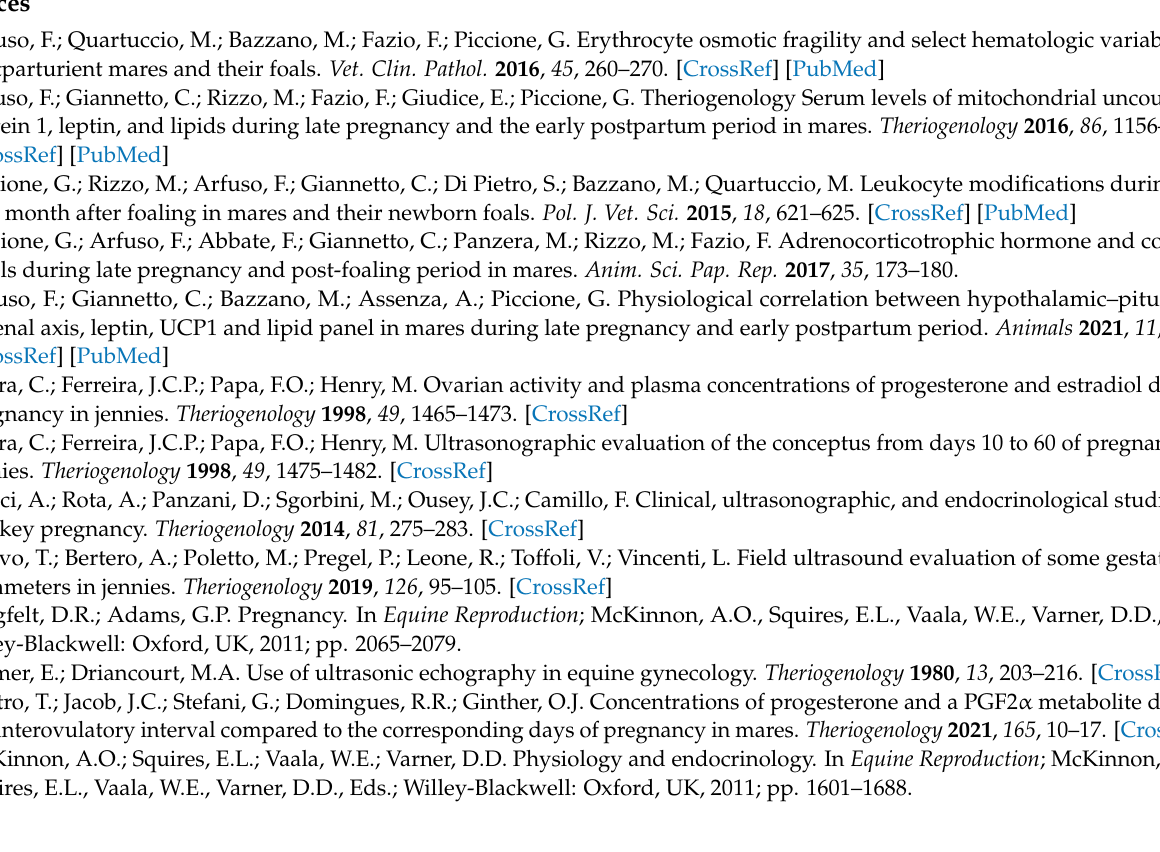
embryonic vesicle (EV) diameters during the first 30 days of pregnancy in eight Caribbean jennies. Day of ovulation, day 0. Figure S3. Mean ± SEM diameter of embryonic vesicle from the day of detection (Day 9–10) to Day 30 of pregnancy for embryos surviving at least to 30 days (Normal pregnancy), and for one individual pregnancy that terminated spontaneously 22 days after ovulation (Failed pregnancy). Table S1. Mixed effects linear regression coefficients for CL volume for the first 10 days after ovulation, with the jenny as random variable. Table S2. Mixed effects linear regression for progesterone concentration for first 10 days after ovulation, with the jenny as random variable. Table S3. Mixed effects linear regression coefficients for embryonic vesicle diameter, including the jenny as random variable, up to Day 18 after